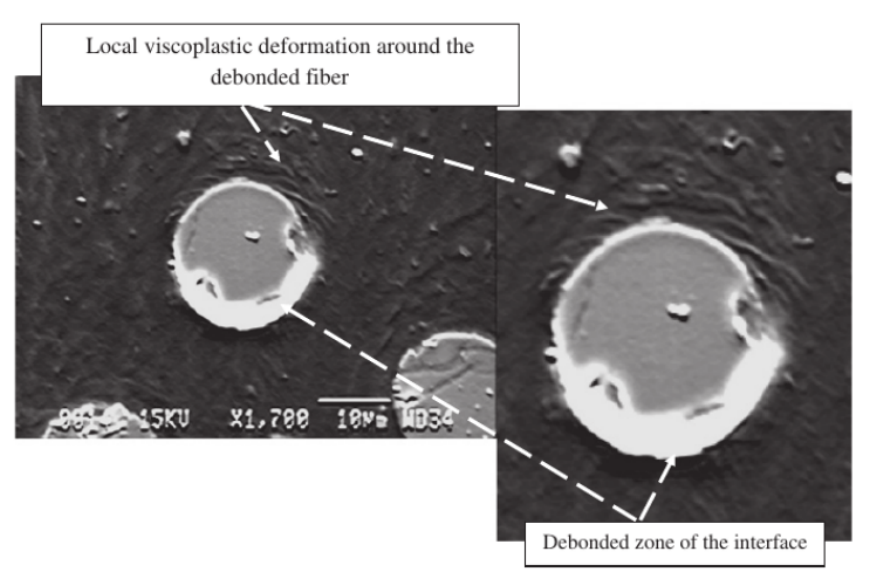
Figure 13. Matrix local viscoplastic deformation around a debonded fiber [53].